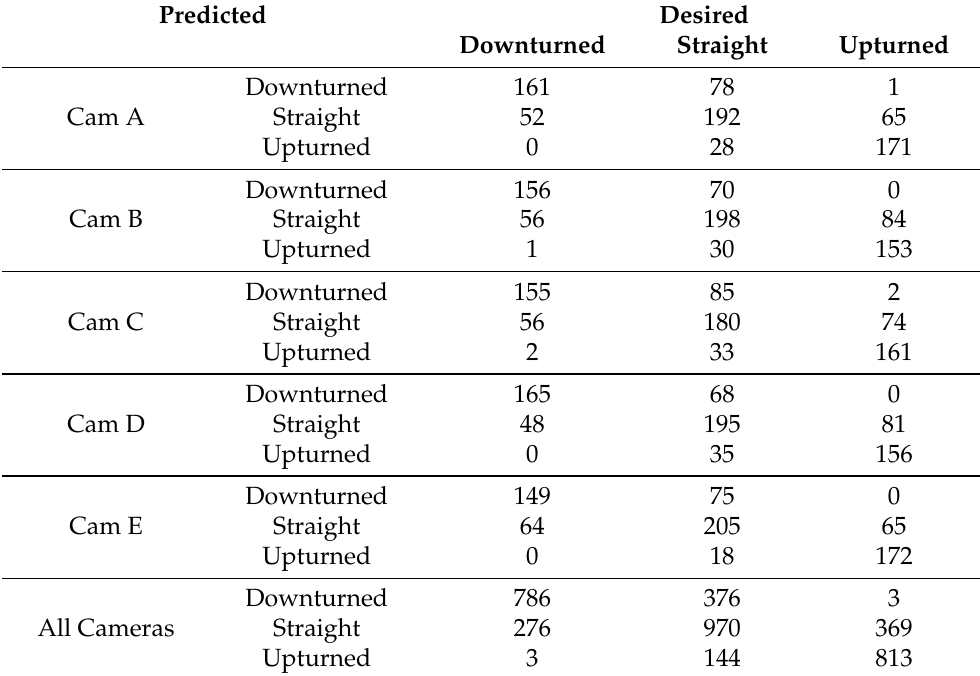
Table A3. Confusion matrices depict eye position attributes prediction in each webcam versus the ground truth.